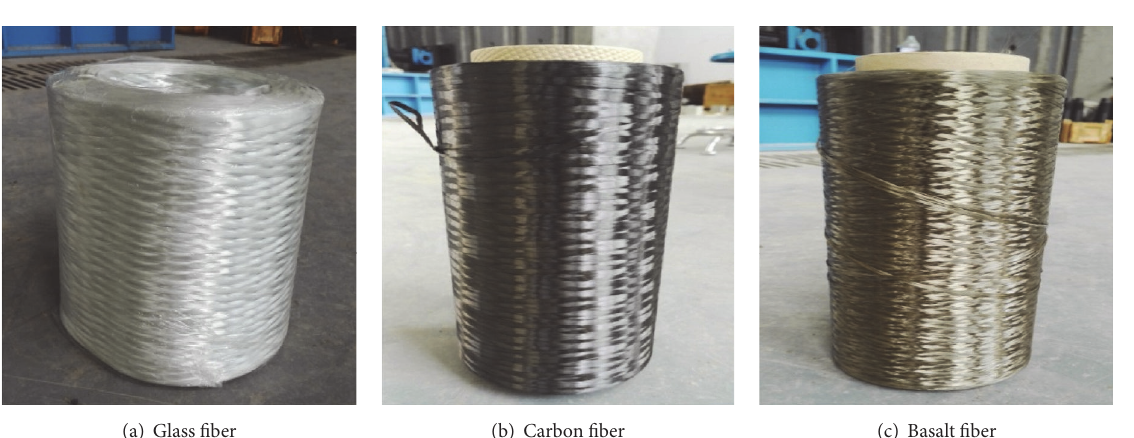
Figure 2: Fiber yarns used in the experiments.